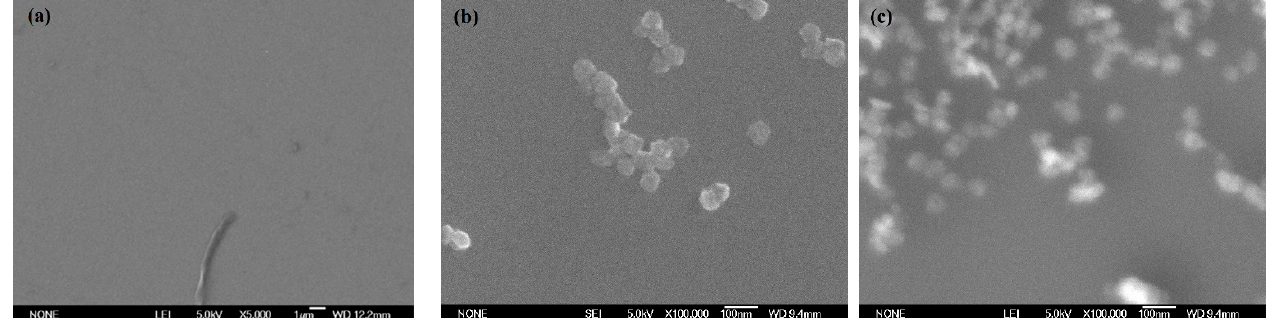
Figure 6. SEM morphology of the TiO 2 nanoparticles adsorbing on the Si workpieces. ( a ) Original Si surface, ( b ) nanoparticle colloid jet adsorption surface, and ( c ) UV-induced nanoparticle colloid jet adsorption surface.